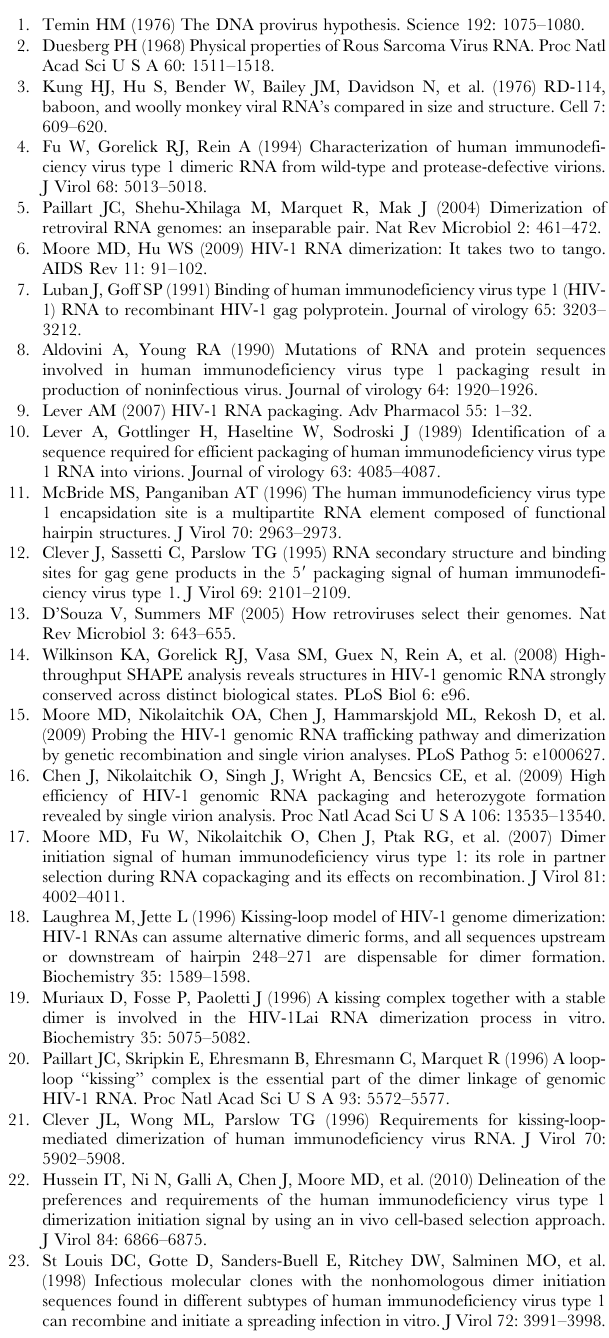
Table S5 Effects of DIS sequences on the percent of heterozygous particles containing HIV-1 RNAs with two dimerization signals. * The percent of heterozygous particles in each sample was compared to the average percent of heterozygous particles for Base-MSL + Base-BSL samples in Supplemental table S2 that was set to